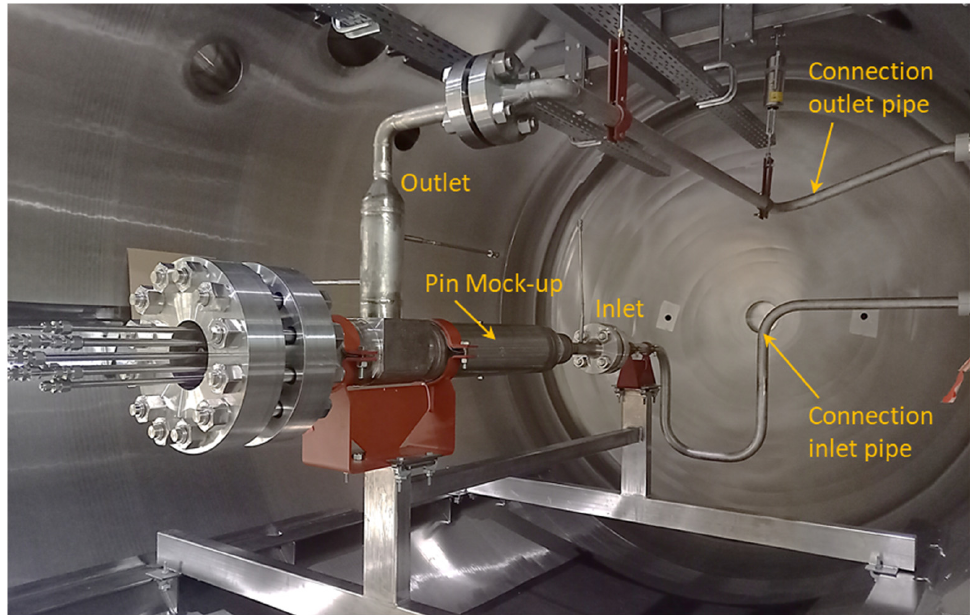
Figure 4. The pin MU is installed inside the vacuum vessel of HELOKA Test Section 1.